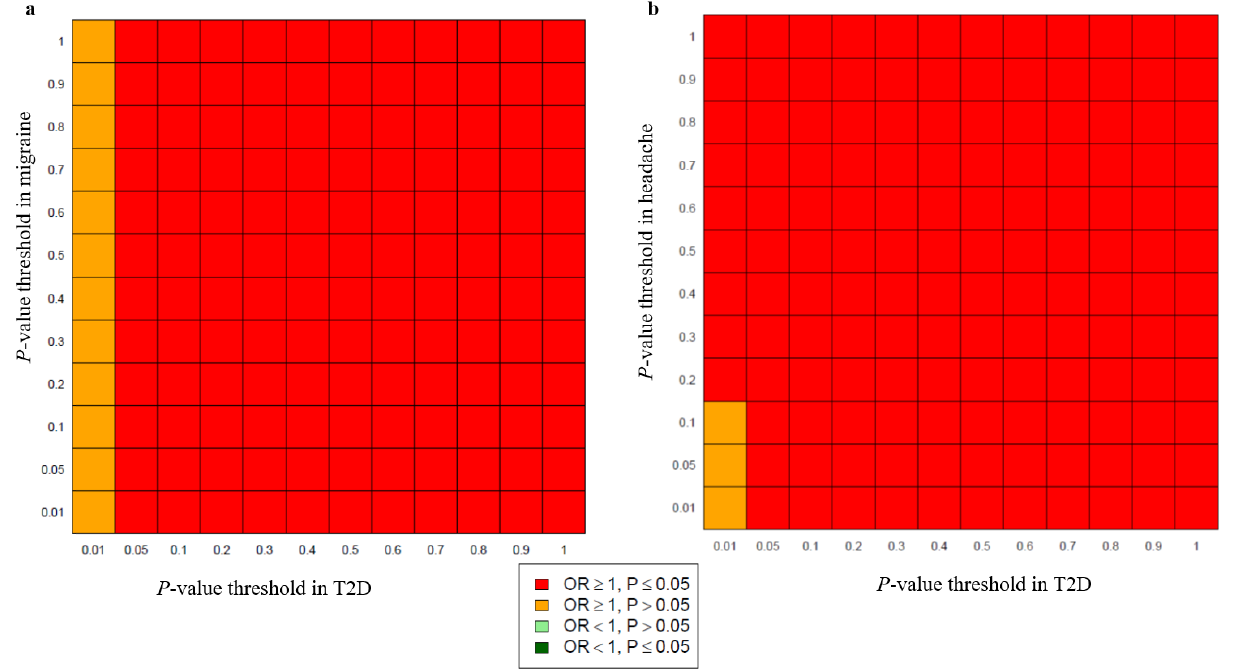
Figure 2. Genetic overlap between migraine and T2D, and headache and T2D . Heatmap plots from SECA exact Fisher tests for SNP effect concordance between ( a ) migraine and T2D, and ( b ) headache and T2D. Among the 144 SNP subsets examined, 132 and 141 SNP subsets (red colour in the figure) showed significant concordant effects (OR > 1 and P < 0.05) between migraine and T2D and between headache and T2D, respectively.